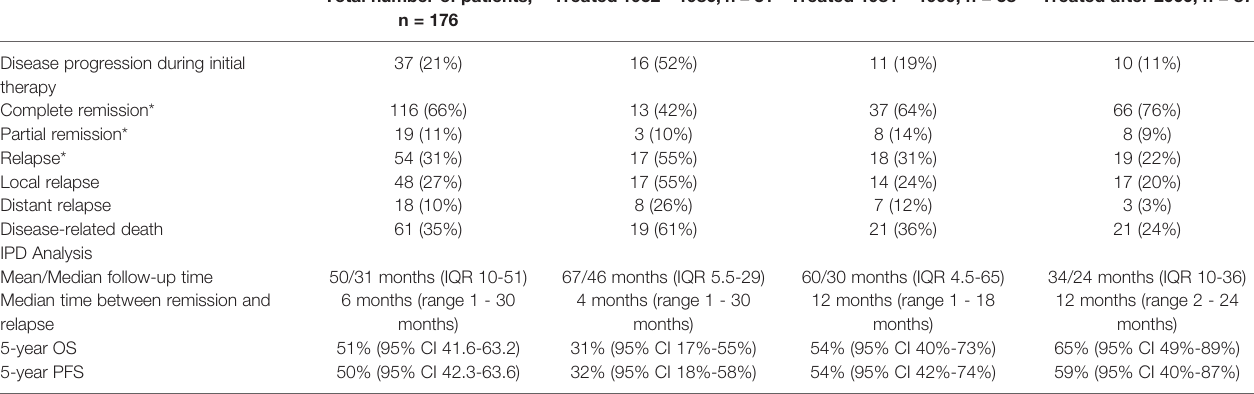
TABLE 6 | Patient outcome and IPD analysis.